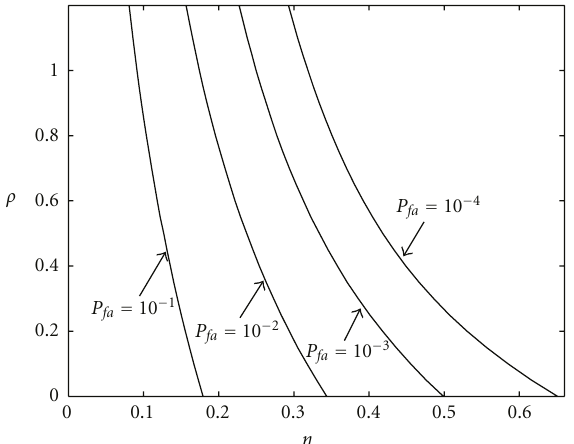
Figure 1: Contours of constant P fa for the KRAO versus η and ρ with N = 8, K =